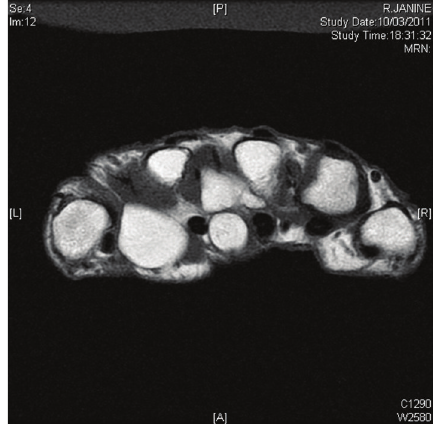
Figure 2: MRI axial view showing distal extension of lipoma in the first metacarpal space.